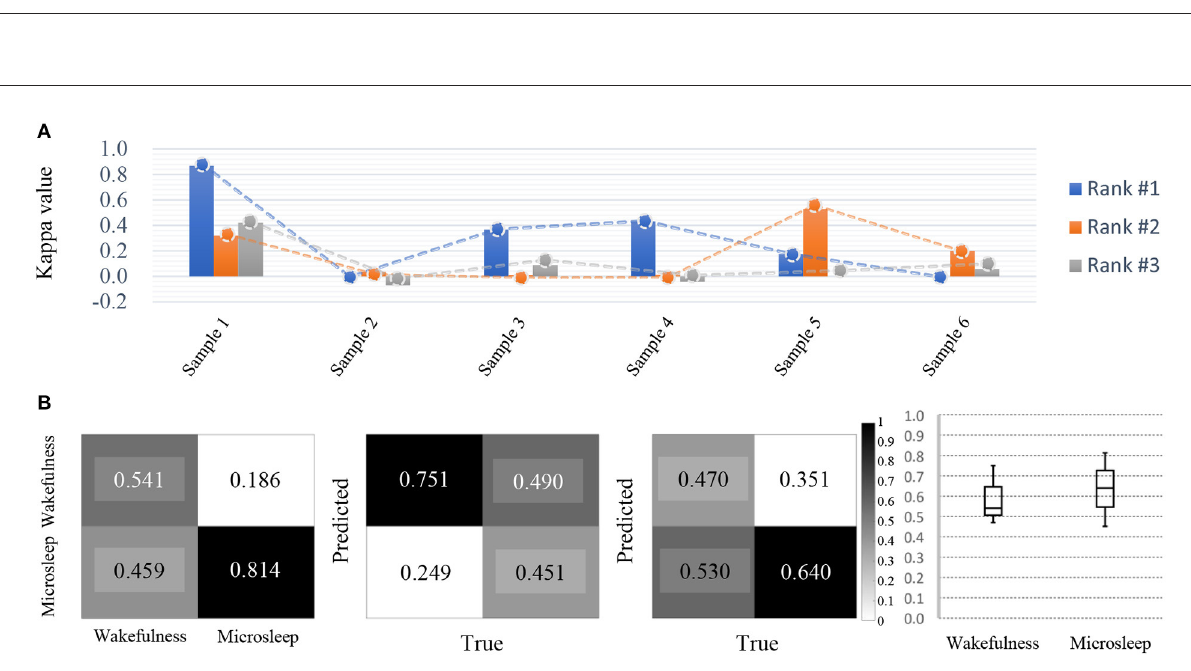
FIGURE6 Competition outcomes. (A) Micro-sleep detection results (kappa value) and achieved decoding performance indicating large deviations among participants. All participants show relatively large decoding performance deviations for each sample. (B) For micro-sleep detection, despite being the top-ranked models, detection accuracy is still insufficient and there is a large deviation in the performance achieved by each participant (based on Cohen’s kappa